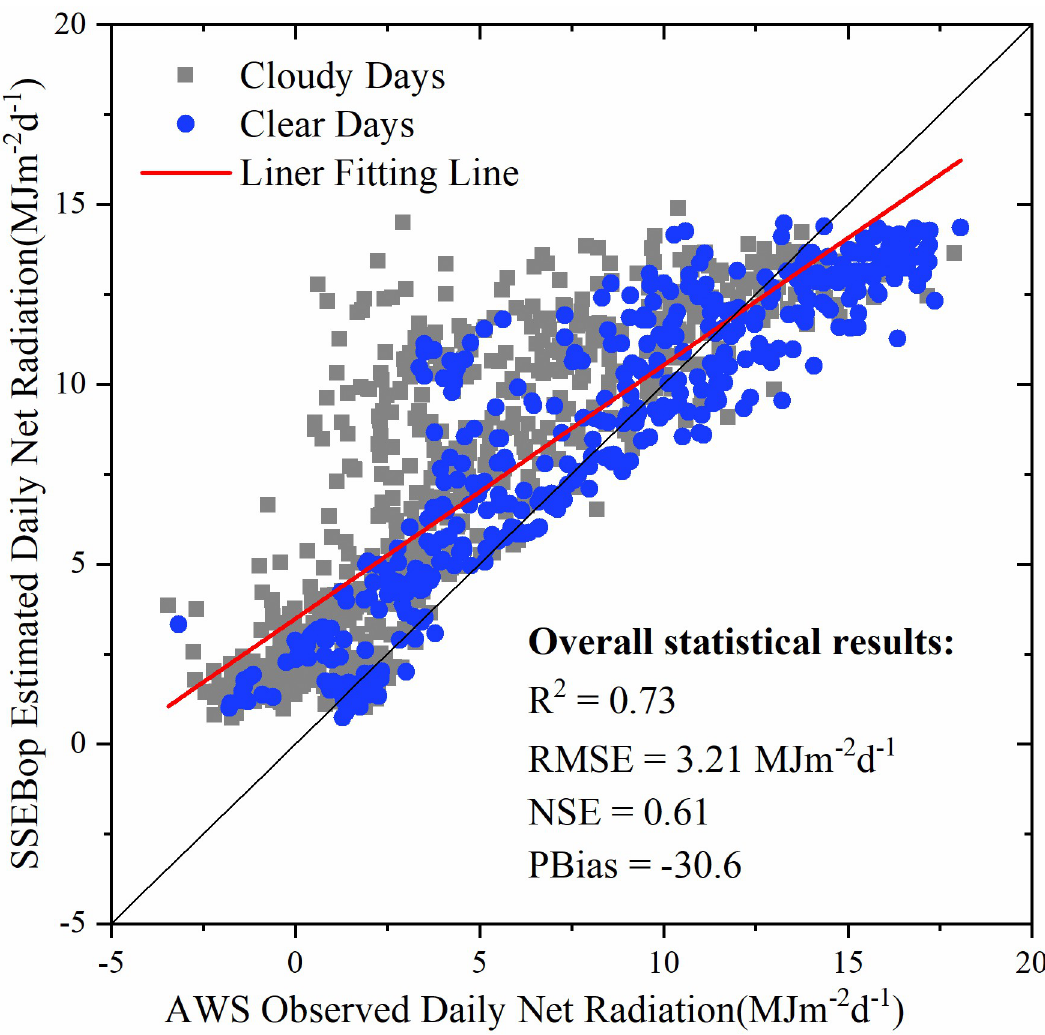
Fig 3. The scatter plot of the SSEBop “averaged-sky” net radiation versus the AWS observation from 2013 to